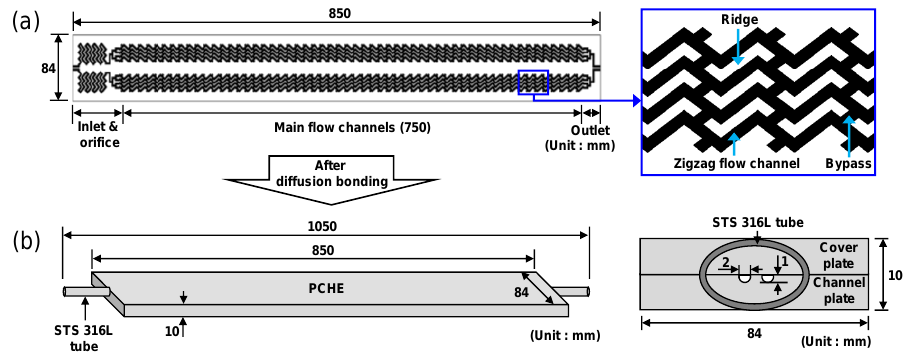
Figure 1. Manufacturing processes and detailed dimensions of the PCHE: ( a ) geometry of the flow channels; ( b ) after the diffusion bonding process.